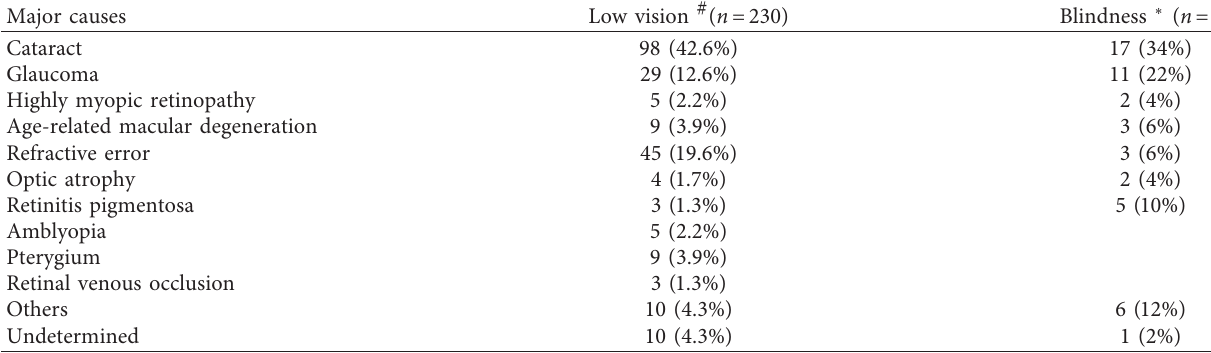
Table 5: Causes of low vision and